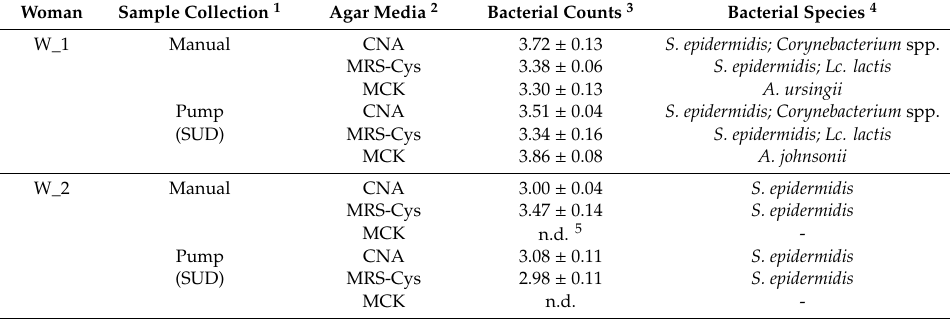
Table 1. Bacterial counts (log 10 cfu / mL) in the milk samples obtained either by manual expression or pumping in this study and identification of the diverse types of colonies observed in the di ff erent agar media where growth was